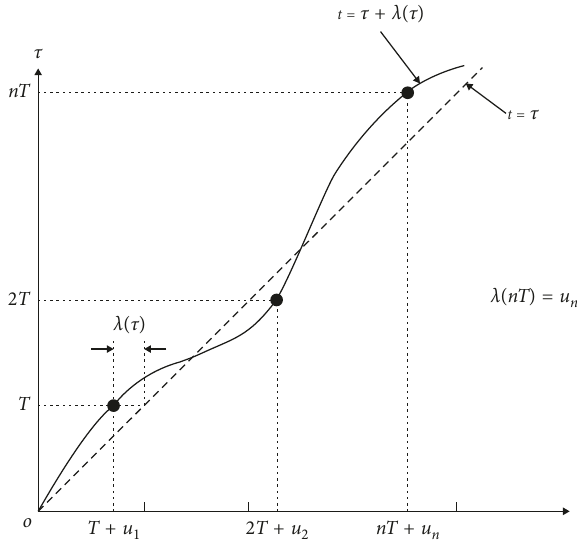
Figure 2: The schematic of nonlinear time transformation of BTT sampling times under speed